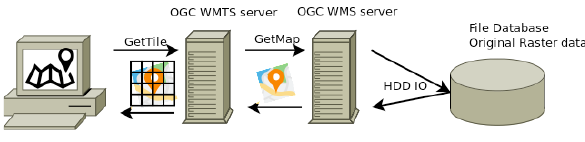
Figure 1: OGC OWS services - Client application requires pre- defined tiles, they are generated from another mapping service and cached on the WMTS server. WMS service is generated from original raster